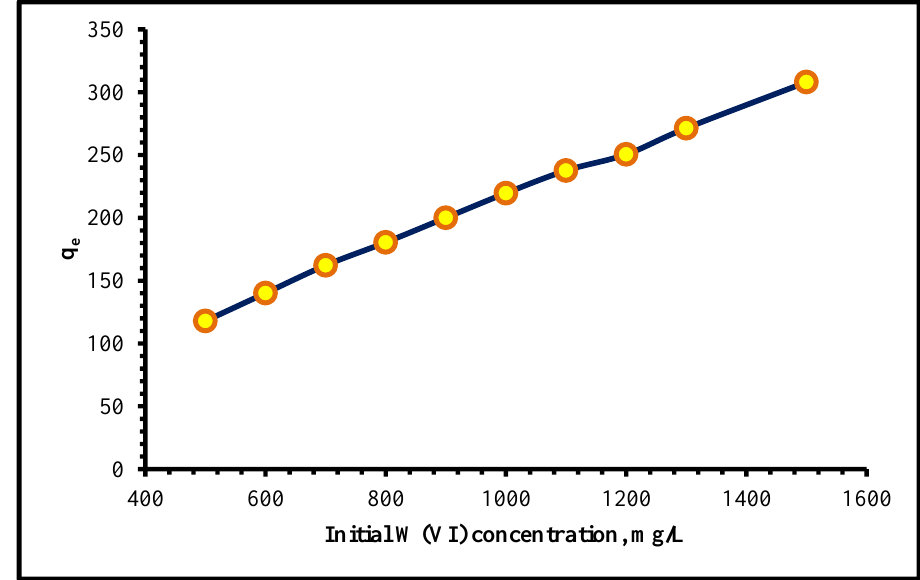
Figure 11. Effect of initial W(VI) ions concentration on the adsorption % of W(VI) using HNAP/QA (pH 4.5, 20 mL solution, 30 min, 0.08 g, room temperature).